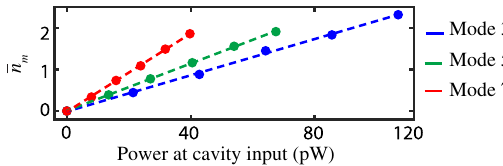
FIG. 8. Phonon number power dependence. The average phonon number extracted from the measurements depends linearly on the power applied to each